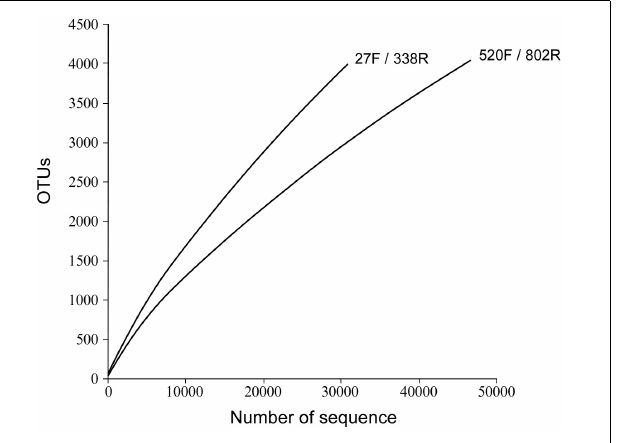
FIGURE 4 | Rarefaction curves of OTU diversity defined at 0.03 distance cutoff for each of the 16S rRNA gene amplicon libraries prepared from flocculent material collected throughout the spent nuclear fuel storage basin.